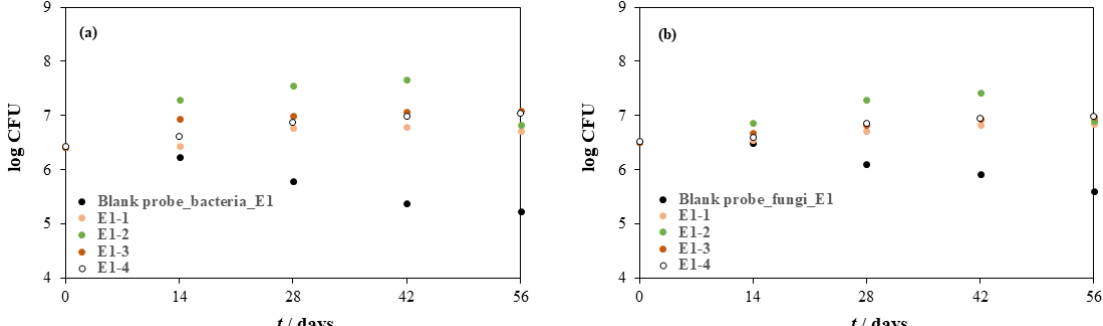
Figure 4. Change of CFU of bacteria ( a ) and fungi ( b ) in experiments E1 during 56 days of biodegradation experiments.